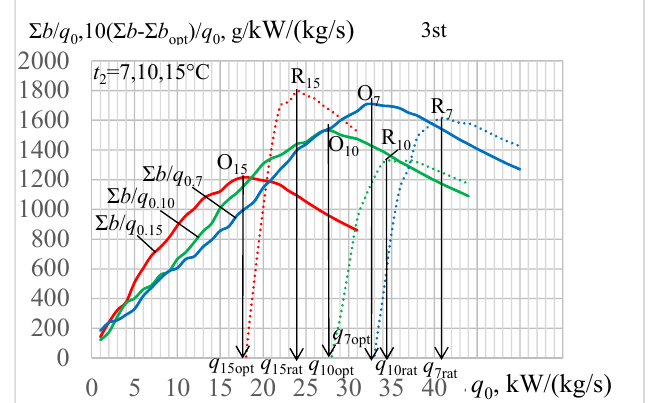
(cid:80) (cid:80) (cid:80) b / q 0 and ( b − b opt ) / q 0 · due to (cid:80) (cid:80) b / q 0 ; − ( b −